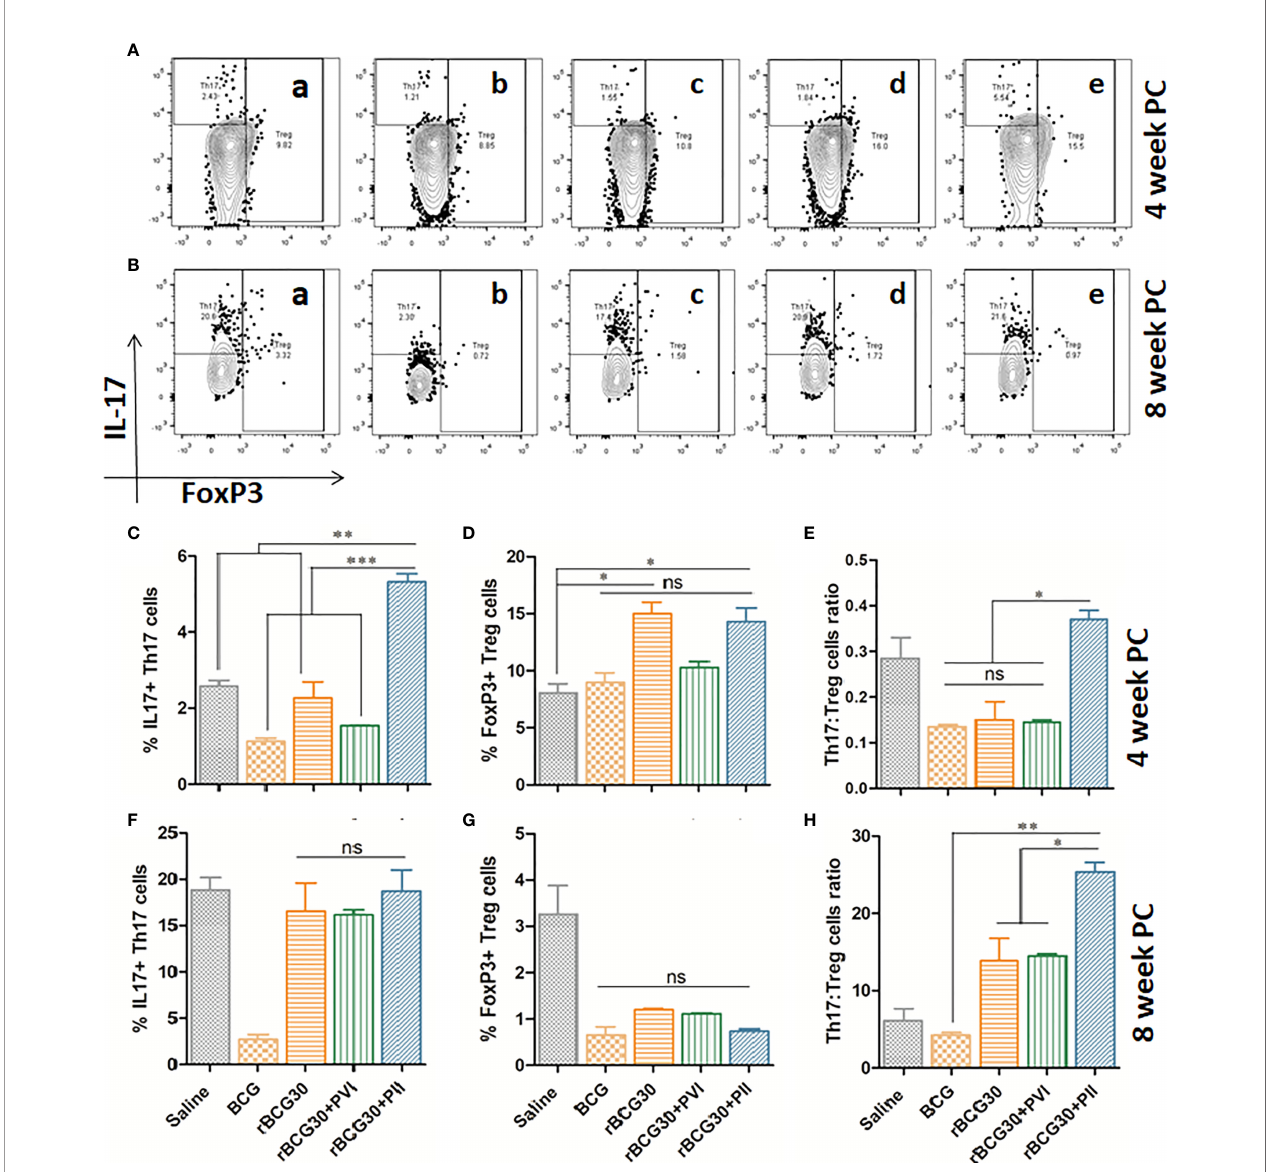
FIGURE 9 | Th17/Treg cells dynamics in response to DPP based immunotherapy. Representative FACS micrographs in upper panel depicting Th17/Treg frequency at (A) 4 and (B) 8 weeks PC with groups labels (a) Saline, (b) BCG, (c) rBCG30, (d) rBCG30+5,15-DPP (PVI), and (e) rBCG30+5,15-DPP (PII), respectively. Bar graphs in the fi gure are depicting quantitative magnitude (in percent) of Th17 cells at weeks (C) 4 and (F) 8, Treg cells at weeks (D) 4 and (G) 8, and the ratio of Th17 to Tregs at (E) 4 and (H) 8 weeks PC. The level of signi fi cance of the data was tested using Two-way ANOVA followed by Tukey ’ s post-test and are shown as means ( ± SEM) from one of the two independent experiments with similar observations performed in at least three biological replicates, where p<0.05(*), p<0.01(**), and p<0.001(***) were considered signi fi cant. ns, non-signi fi